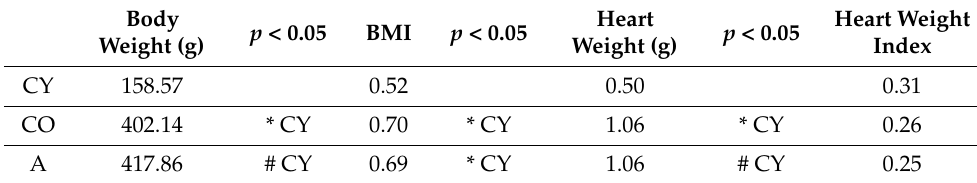
Table 2. Somatometric parameters of test